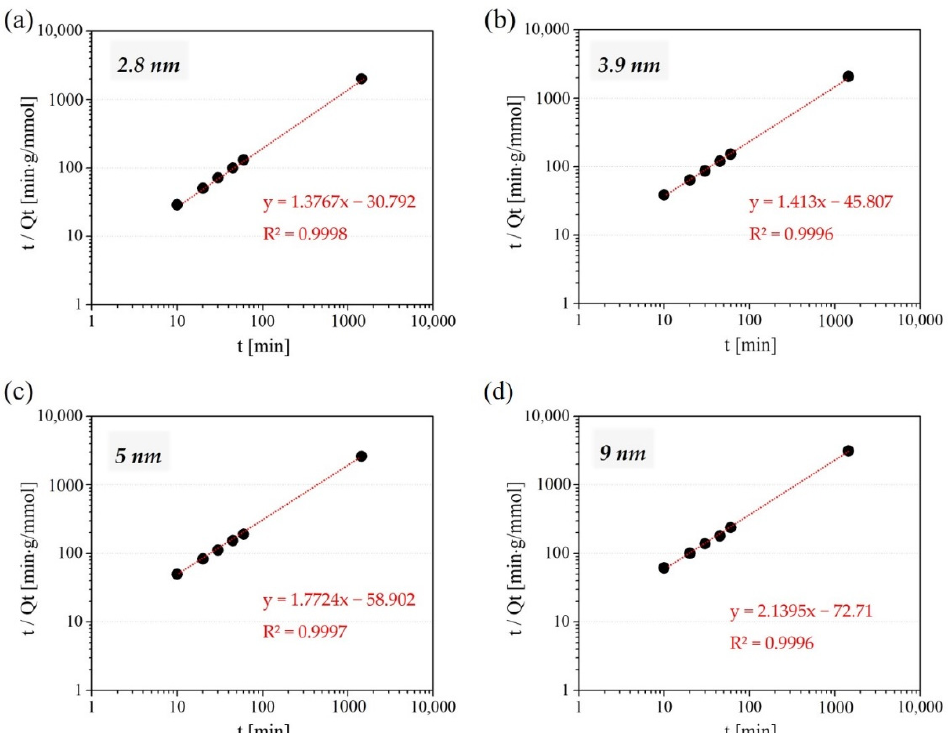
Figure 7. Langmuir plot for Zn adsorption amount on amine-modified MS with the initial MS pore size of 2.8 nm ( a ), 3.9 nm ( b ), 5 nm ( c ), and 9 nm ( d ) in a single-component system ranging from 0.15–2.5 mmol/L of Zn.